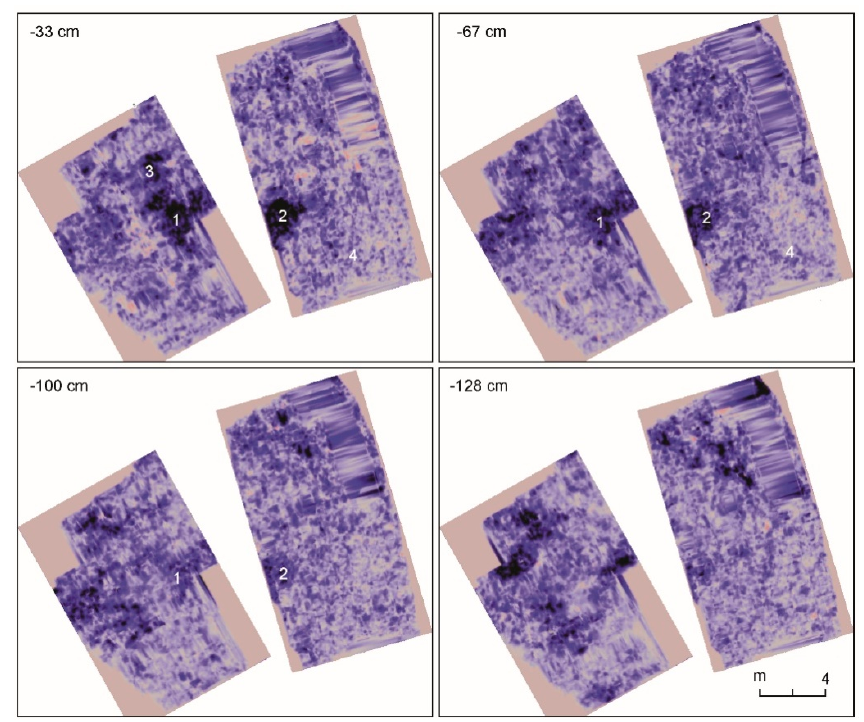
Figure 5. GPR slices of feature 8 at different depth from the ground level.